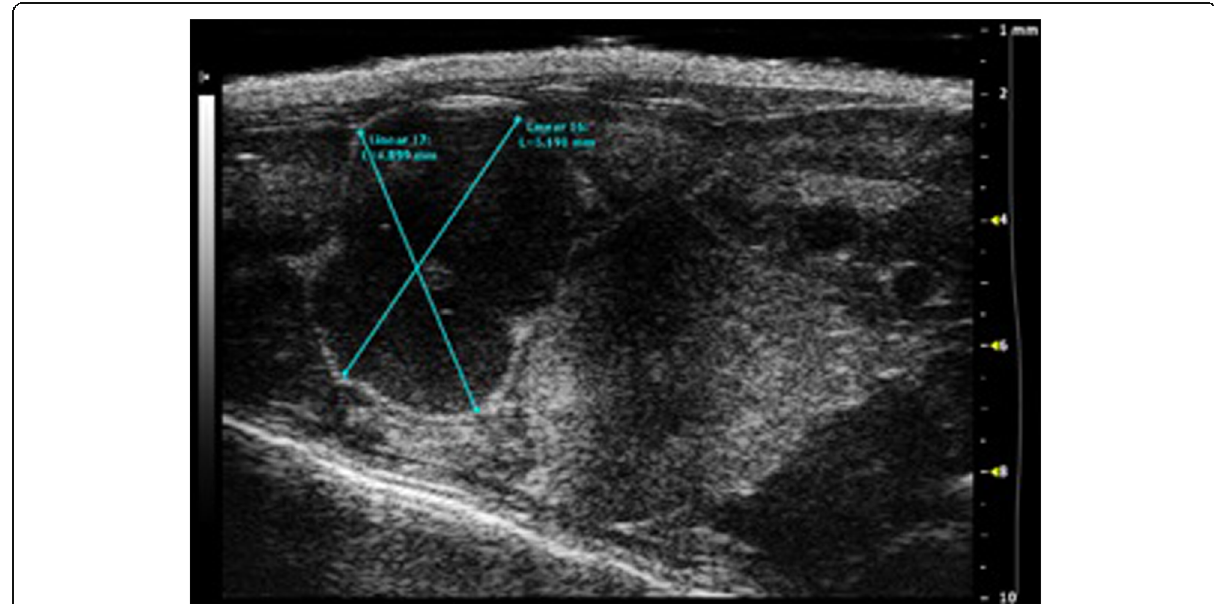
Fig. 2 Ultrasound image showing a large mass in a phosphate-buffered saline-treated mouse (control) in the abdomen (right iliac